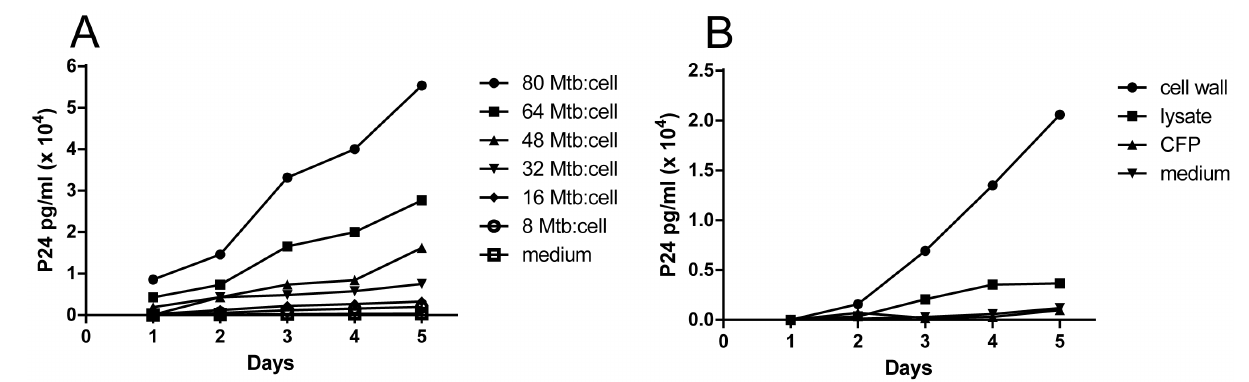
Figure 8. Effect of M.tb on HIV-1 p24 production by U1 cells. (A) Effect of gamma-irradiated, intact M. tb on p24 production by U1 cells over 5 days at increasing MOI ( M. tb :cell). (B) Effect of M. tb subcellular fractions- cell wall, lysate, and culture filtrate proteins (CFP) at 20 ug/ml on U1 p24 production over 5 days. U1 culture medium alone represents the negative control in both assays. Shown are representatives of two or more experiments.